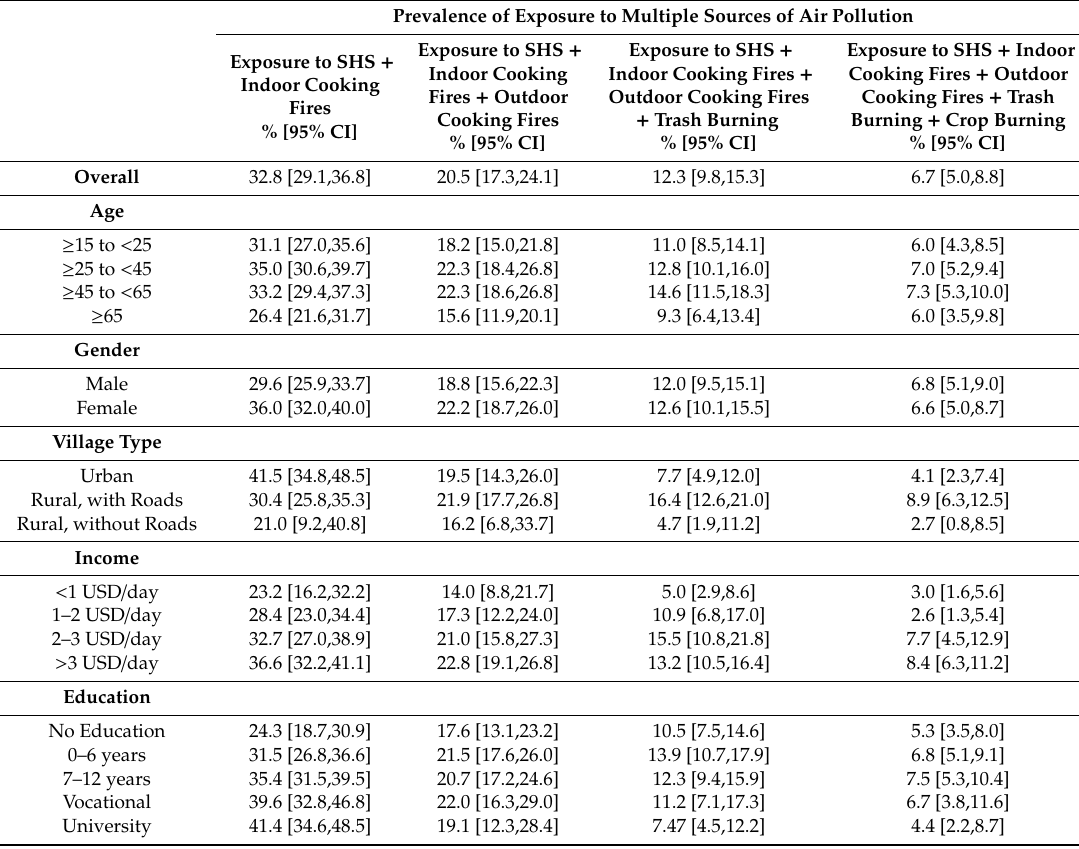
Table 2. Overall prevalence of exposure to multiple combined sources of household and ambient air pollution among 9043 subjects of the 2012 National Adult Tobacco Survey of Laos (NATSL 2012) and prevalence by demographic variables (95%